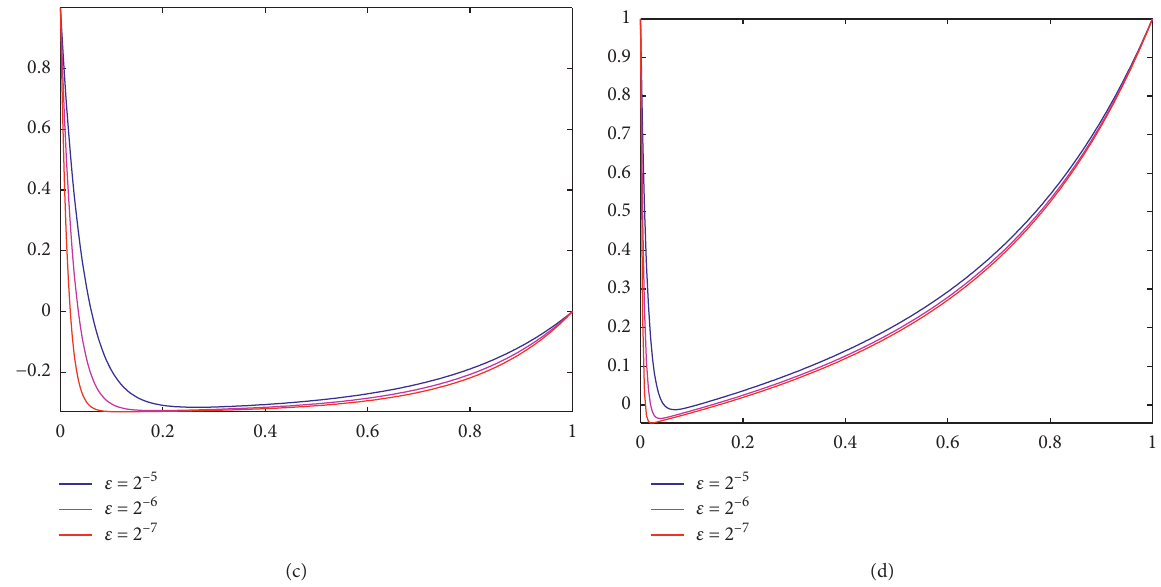
Figure 2: Boundary layer formation as ε goes small. (a) Example 1. (b) Example 2. (c) Example 3. (d) Example